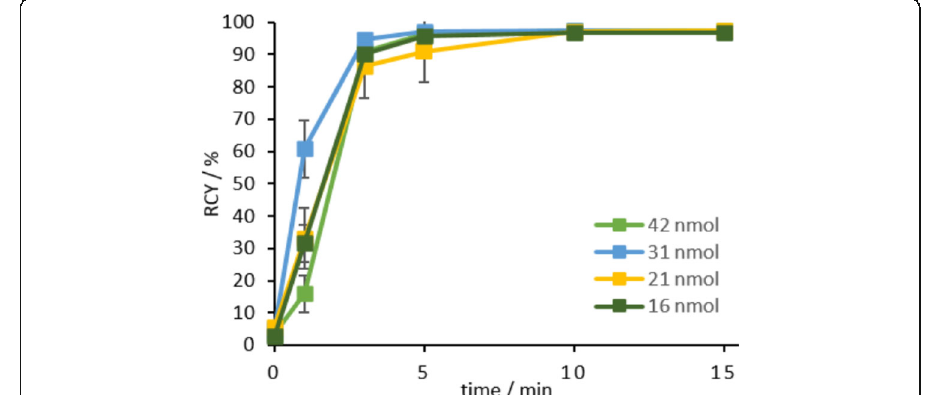
Fig. 5 Radiolabeling kinetics for various amounts of [ 68 Ga]Ga-DOTA.SA.FAPi complex at 95 °C, precursor amounts > 15 nmol result in RCY > 97% after 15